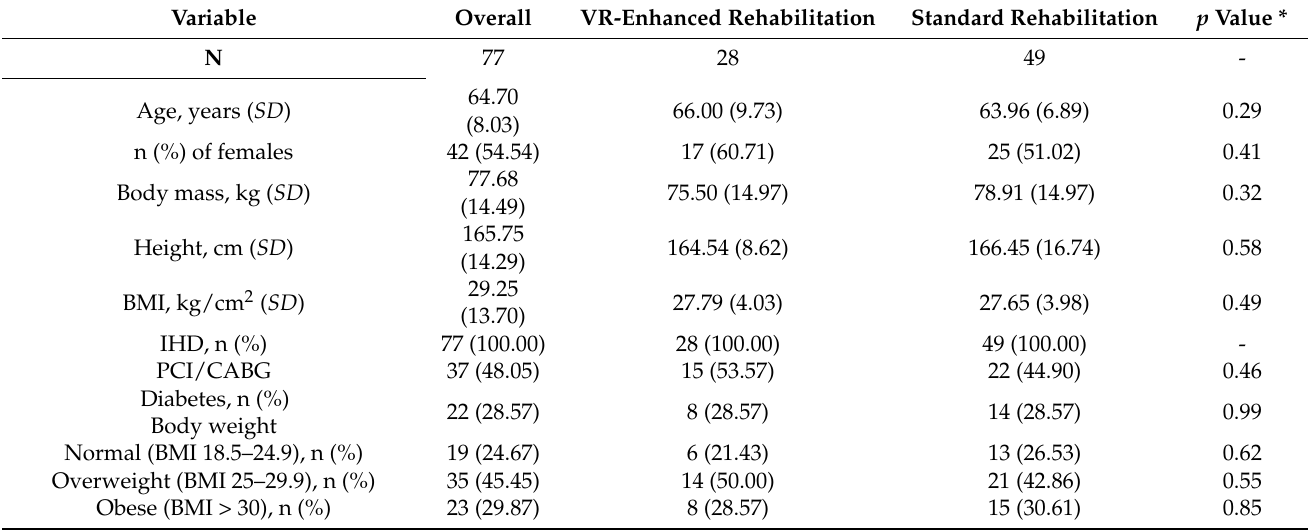
Table 1. Participants’ baseline characteristics.